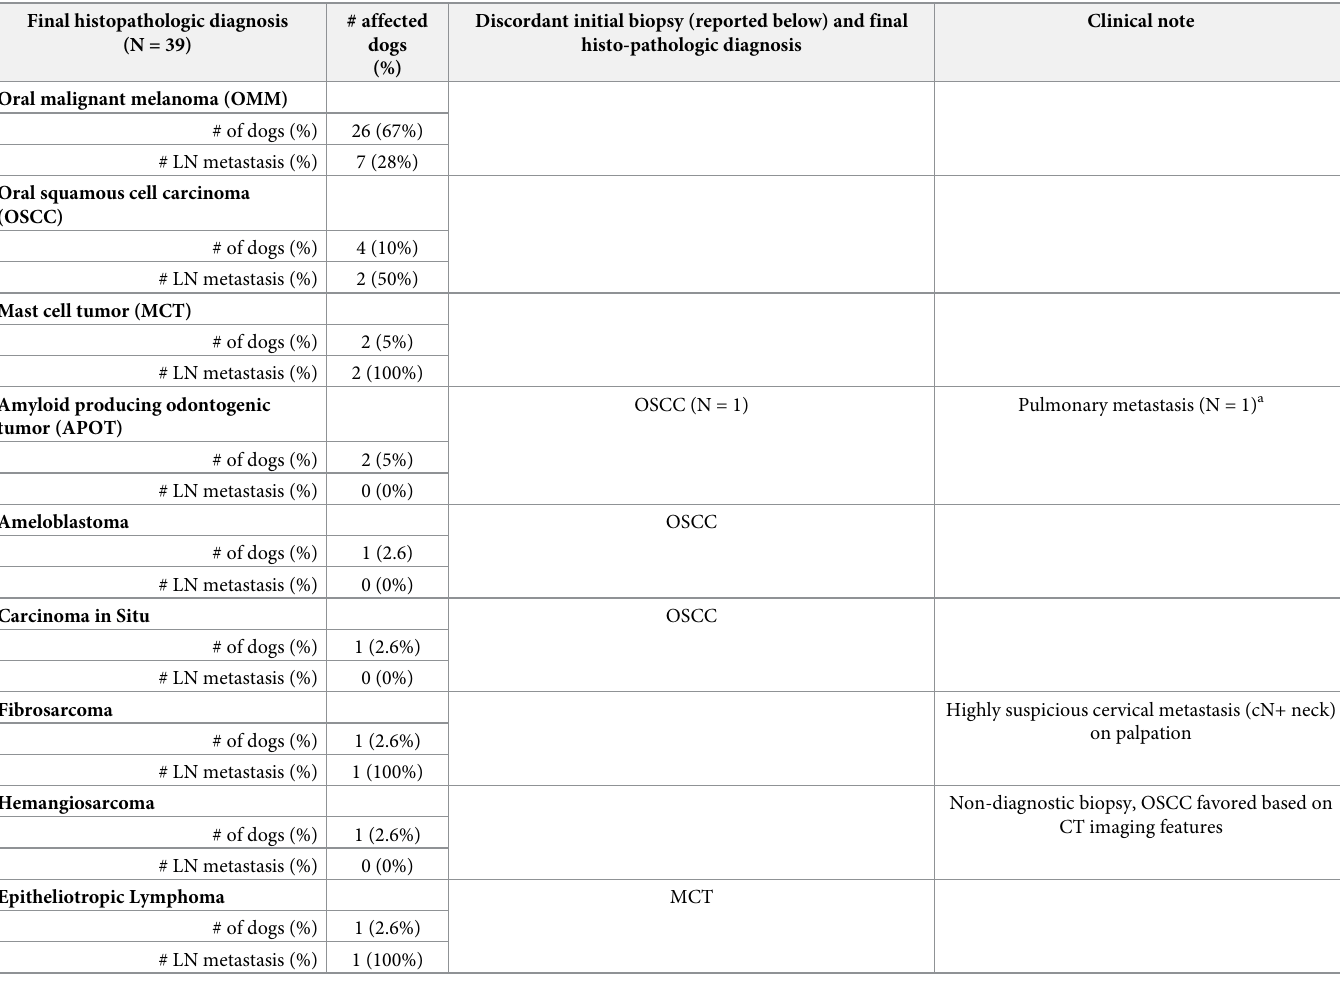
Table 3. Histopathologic diagnosis of tumor types and presence or absence of LN metastasis in dogs with oral tumors. Final histopathologic diagnosis (N =